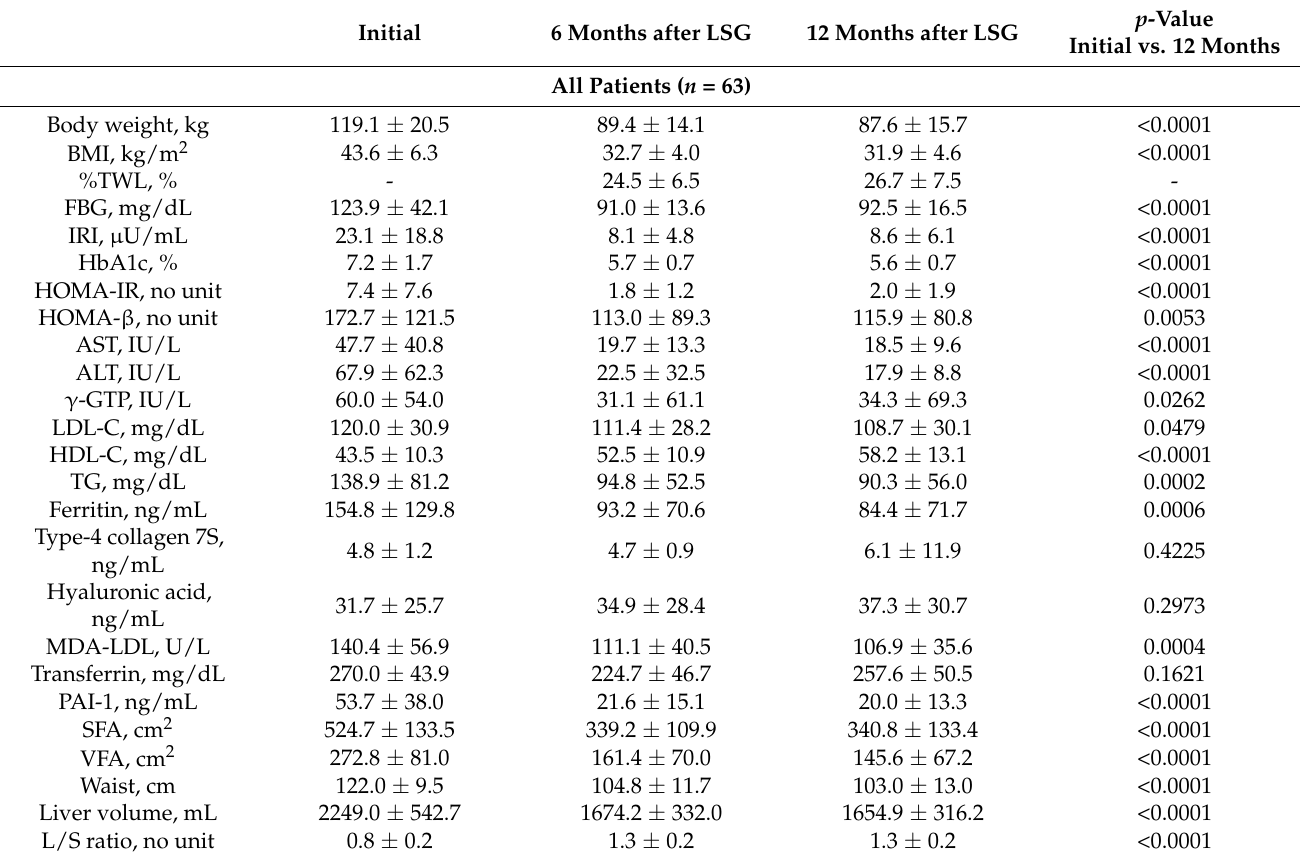
Table 2. Weight-loss effects and changes in metabolic parameters before and after